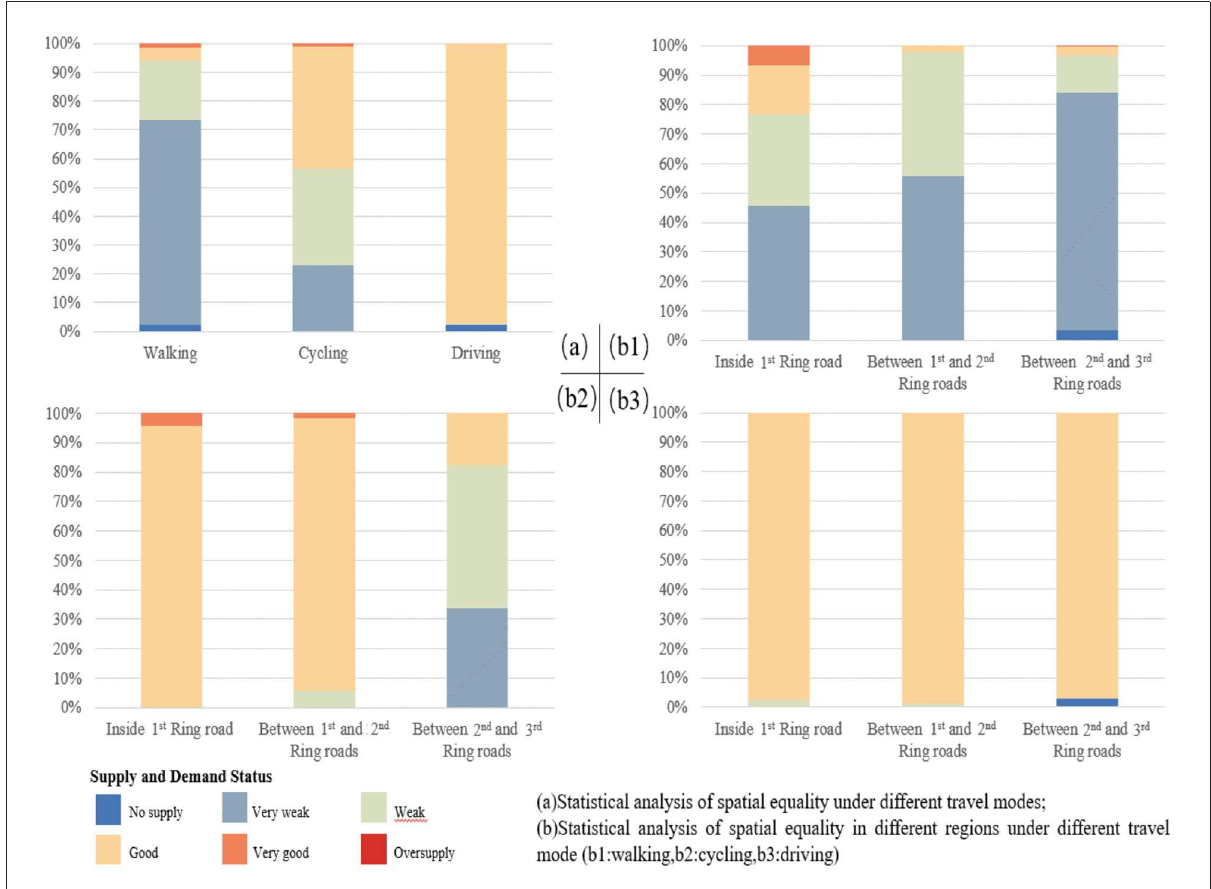
FIGURE10 Statistical analysis of Spatial equality distribution under different travel modes in Chengdu,